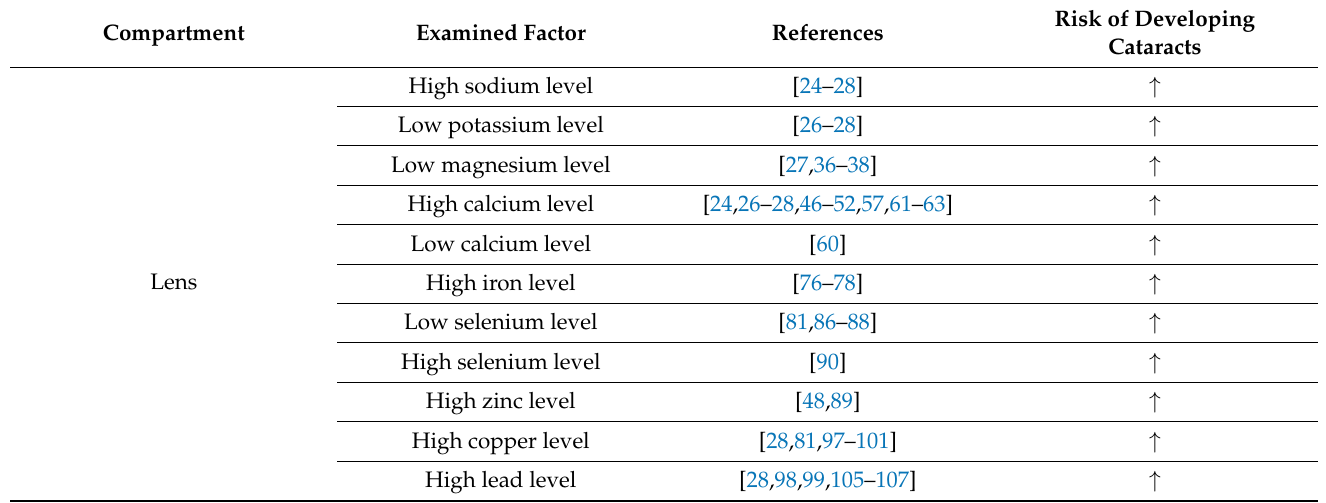
Table 3. Levels of selected micro and macroelement and associated risk of developing cataracts depending on